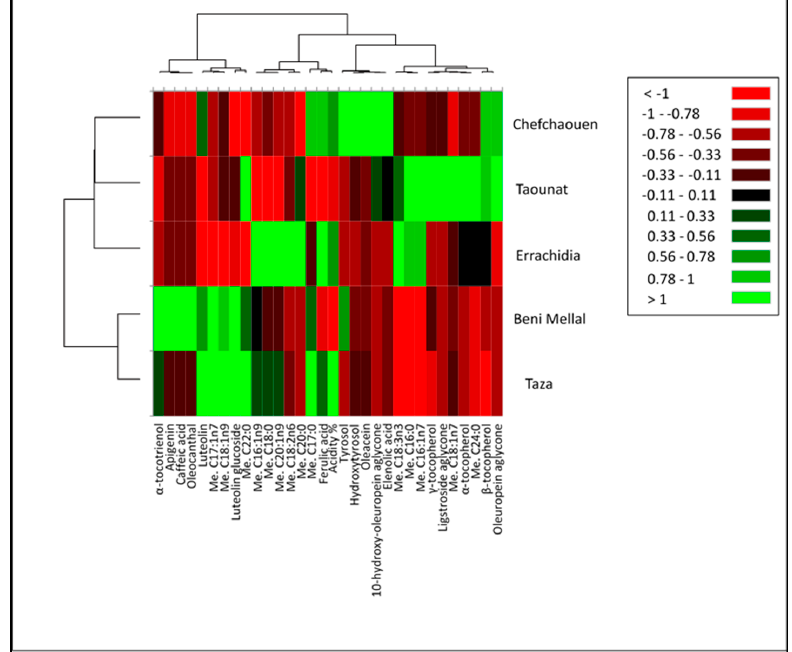
Figure 2. Heat map showing the distribution and concentration of phenolic compounds, fatty acids and vitamin E in VOO of Picholine marocaine from five Moroccan provinces. Green boxes mean a concentration higher than the mean value among the studied samples. A red box means lower concentrations.